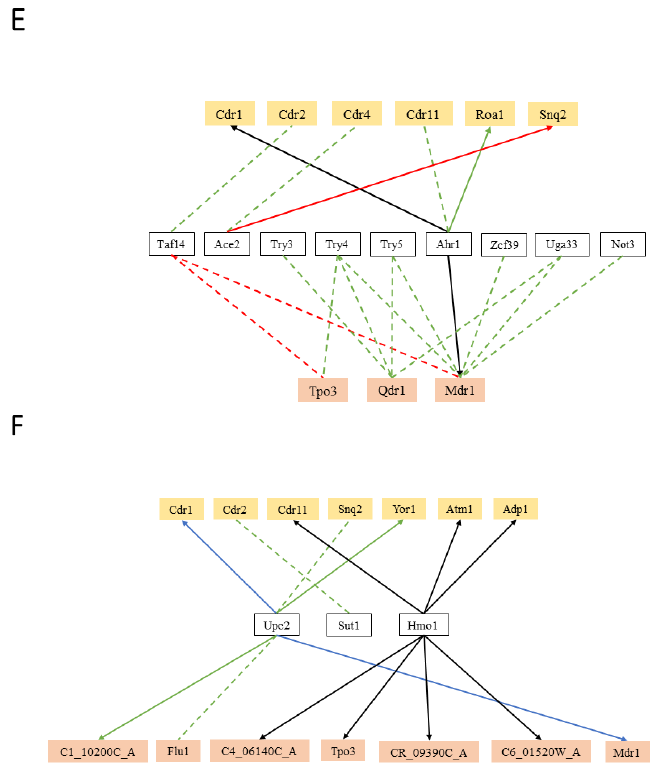
Figure 2. Transcriptional regulatory networks that control the expression of MDR transporter genes in C. albicans , considering the subgroups of transcription factors known to be involved in multidrug resistance ( A ); in stress response ( B ); biofilm formation ( C ); cell-cycle/morphology ( D ); cell-wall dynamics ( E ); and lipid ( F ). The displayed regulatory associations are according to the data present in the Pathoyeastract database (http://pathoyeastract.org/) [161]. The ABC transporters are highlighted by the yellow colour and the MFS transporters are highlighted by the orange colour. Arrows indicate the experimental basis of the documented regulatory associations, either expression evidence (dashed line) or DNA-binding evidence (filled line). Green, red, blue, or black arrows indicate a positive, negative, positive and negative, or unspecified association, respectively.